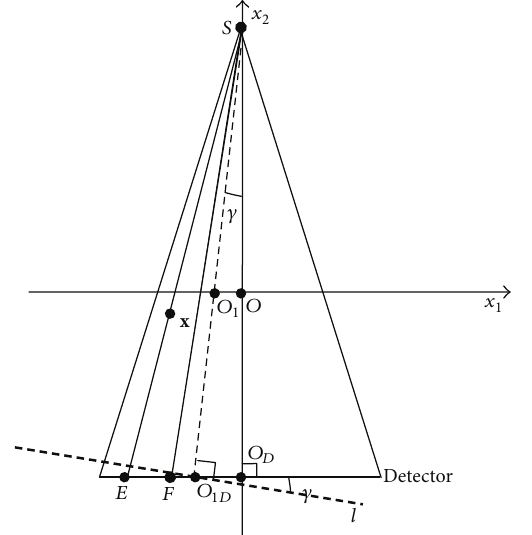
Figure 3: A simple geometric relationship of CT scanning system with the offset of an isocenter.